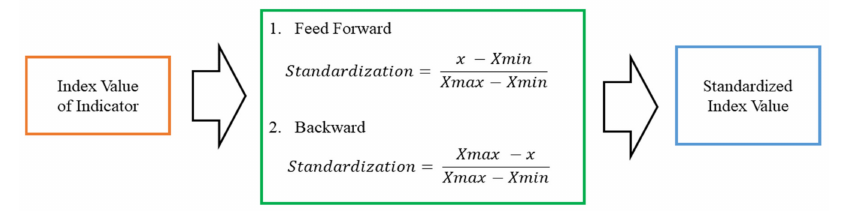
Figure 3. Minimum-to-maximum standardization